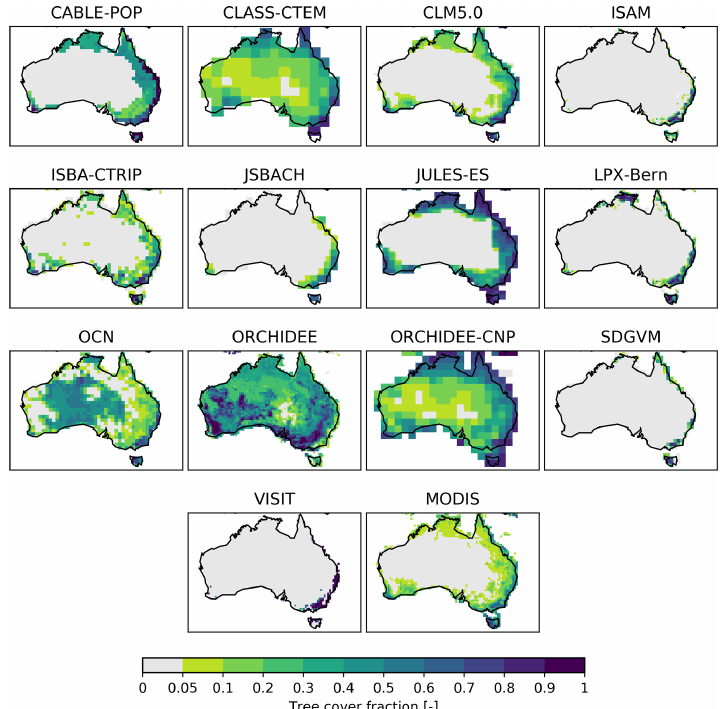
Figure C5. Land-cover fraction of tree vegetation averaged over 2001–2018. Tree vegetation here shows the sum of tree, forest, and shrub PFTs in the TRENDY models. The MODIS panel shows the tree fraction variable from the MODIS/Terra Vegetation Continuous Fields dataset. White areas are missing